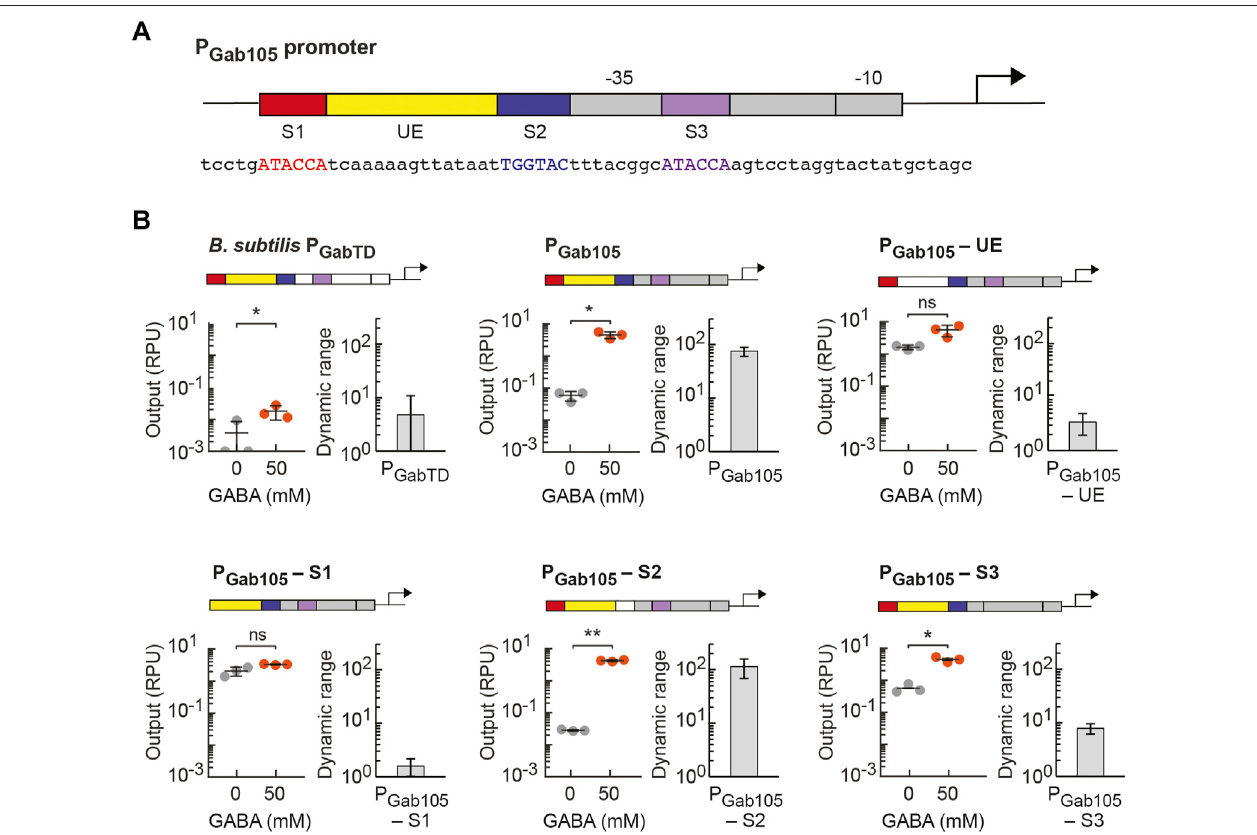
FIGURE 4 | Identifying essentiality of promoter elements in synthetic P Gab promoters regulated by GabR. (A) Genetic schematic of the synthetic P Gab105 promoter designed for E. coli , which contains three putative GabR binding sites (S1, S2 and S3, respectively) and the upstream element (UE) from the native GabR-regulated P GabTD promoter in B. subtilis . The E. coli core promoter sequence (grey) is based on a constitutive promoter (J23105 from the Anderson collection). The sequence between the – 10 and – 35 regions was designed to contain binding site S3 (purple), while the binding sites S1 (red) and S2 (blue) and the UE (yellow) were placed upstream in the promoter sequence. The promoter sequence is also shown. (B) Variants of the P Gab105 promoter were designed to remove either one of the putative bindingsites(S1, S2,orS3)ortheUE.Each ofthepromotervariantsorthenative B.subtilis P GabTD promoterwereassembledintothepML3000prototypingbackbone, whichcontainsGabRunderthecontrolofP Tet .TheresultingsixGABAsensorconstructs,eachcontainingadifferentP Gab promoter,wereassayedwith0.125 ng/mlaTc (0.064RPU)toinduceGabRexpressionwitheither50 mMGABAaddition(orange)orwithoutaddition(grey)tothemedium.Thecell fl uorescencewasmeasuredvia fl ow cytometry, and arbitrary fl uorescence units were converted to standard RPU (Methods). The circles represent measured geometric median of a population of at least 5,000cellsassayedinidenticalexperimentsperformedonthreeseparatedayswiththebarindicatingtheaverageofthereplicates.Thedynamicrangefortheexperiment on each day was calculated as the ratio of the ON to OFF sensor output, and the error bars represent the standard deviation. Student ’ s t -tests (paired, two-tailed) were performed, and p -values ≤ 0.01 (**) and ≤ 0.05 (*) are indicated.